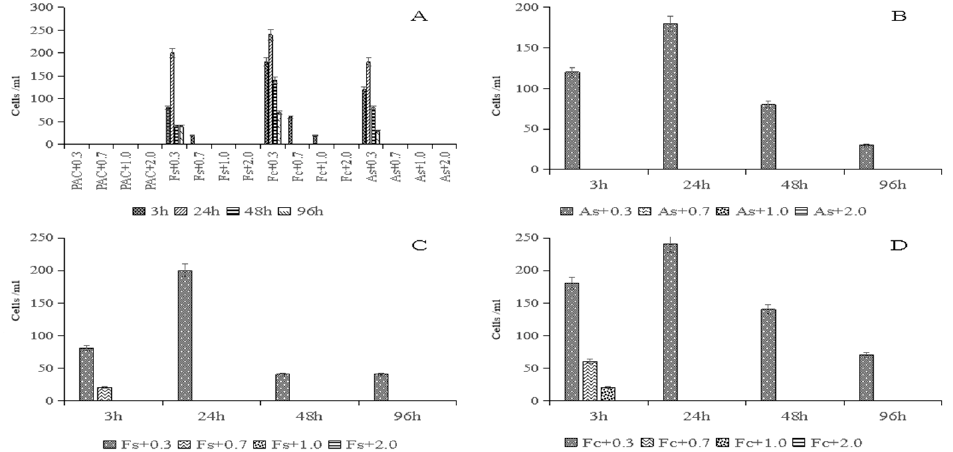
Figure 6. Effects of coagulant and fermentation broth on growth of G. catenatum . ( A ) Combination of four coagulants and fermentation broth to inhibit algae; ( B ) Al 2 (SO 4 ) 3 + Ba3 broth; ( C ) Fe 2 (SO 4 ) 3 + Ba3 broth; and ( D ) FeCl 3 + Ba3 broth.